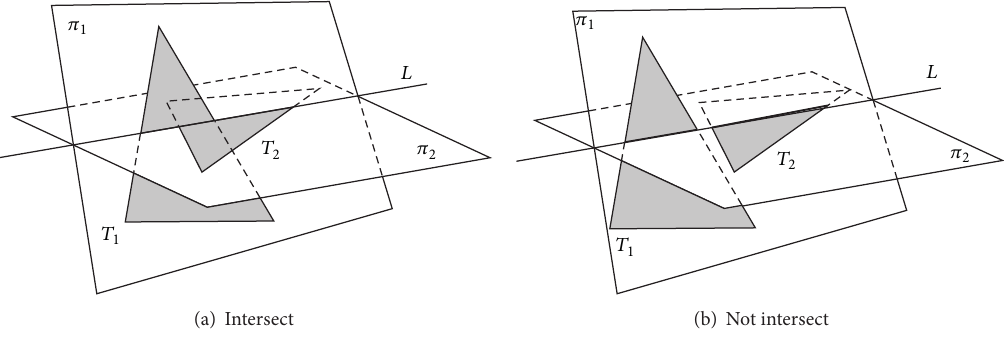
Figure 3: Intersection of triangle with triangle [96].